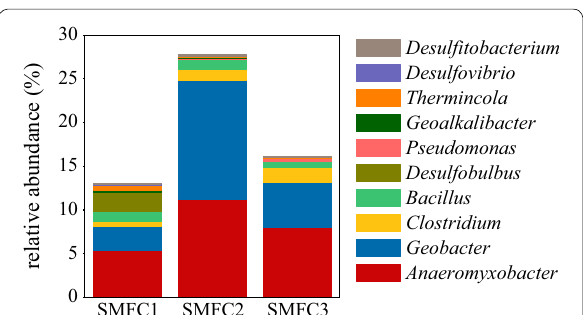
Fig. 4 The relative abundance of the active exoelectrogenic bacteria-associated genera detected from the anodes of the three individual